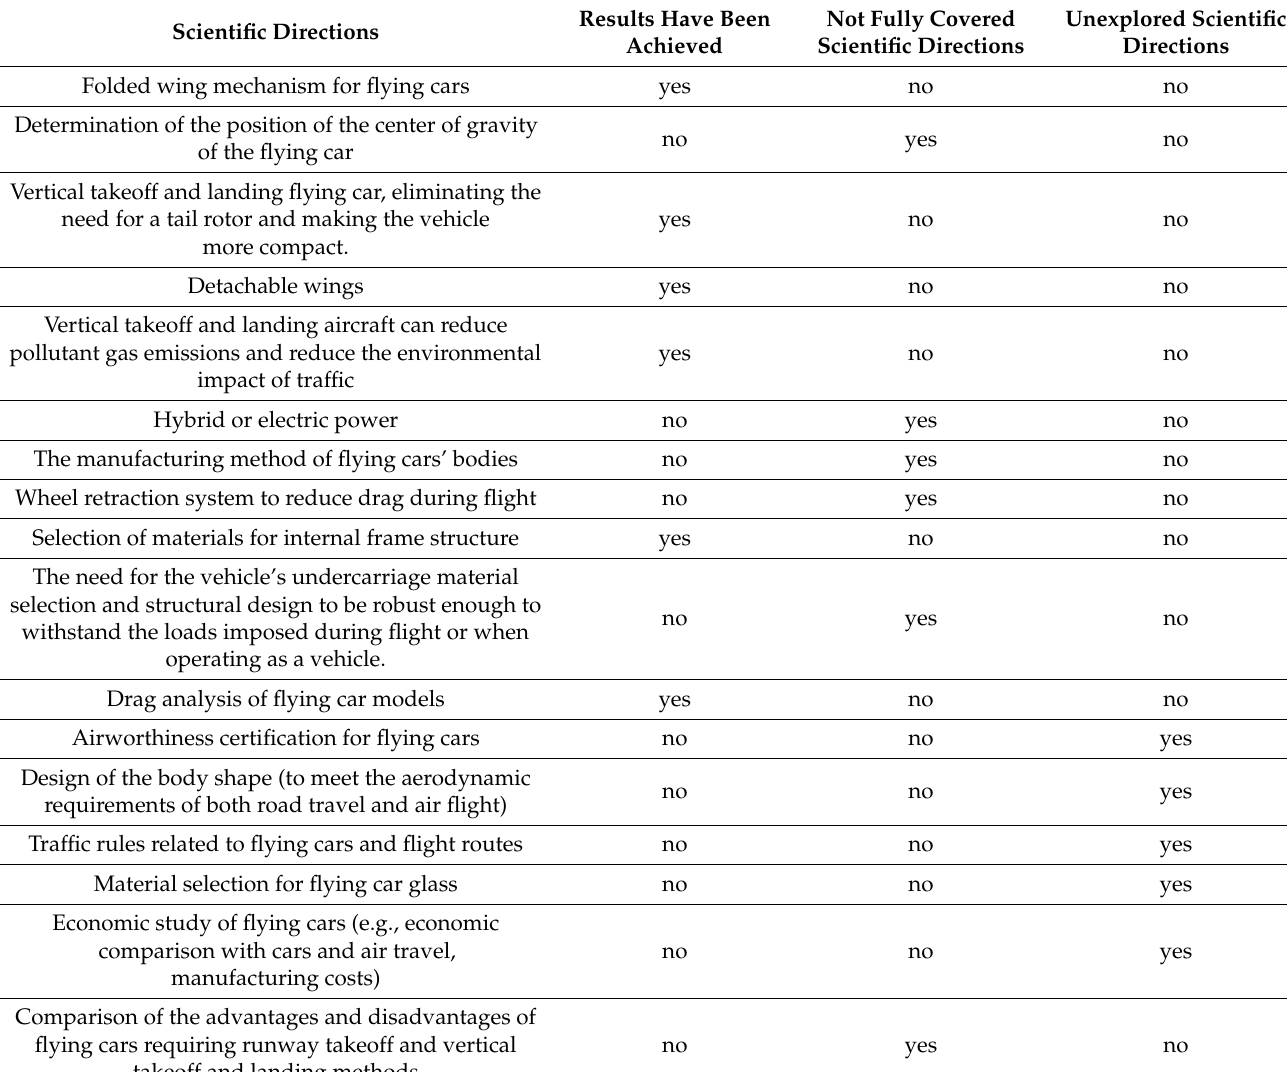
Table 1. Comparison of scientific directions at the preliminary